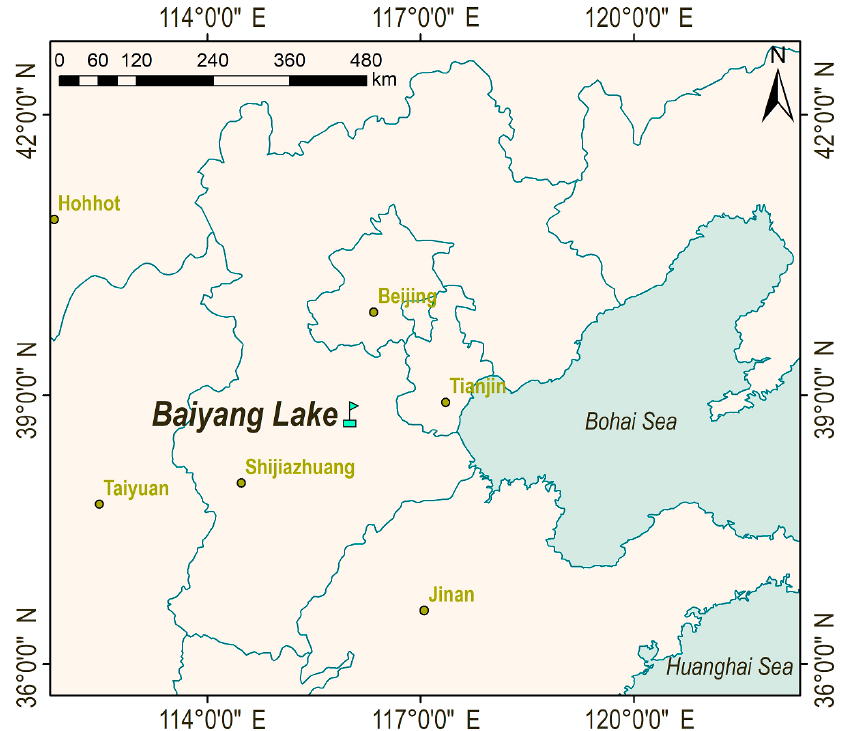
Figure 1. Location of Baiyang Lake. The study area is located 140 km southwest of Beijing, the capital of China. China decided to establish Xiong’an New Area in Xiongxian County, Anxin County, and Rongcheng County on 1 April 2017. Most of Baiyang Lake is under the jurisdiction of Xiong’an New Area and has become an important ecological water body for the development of Xiong’an New Area.